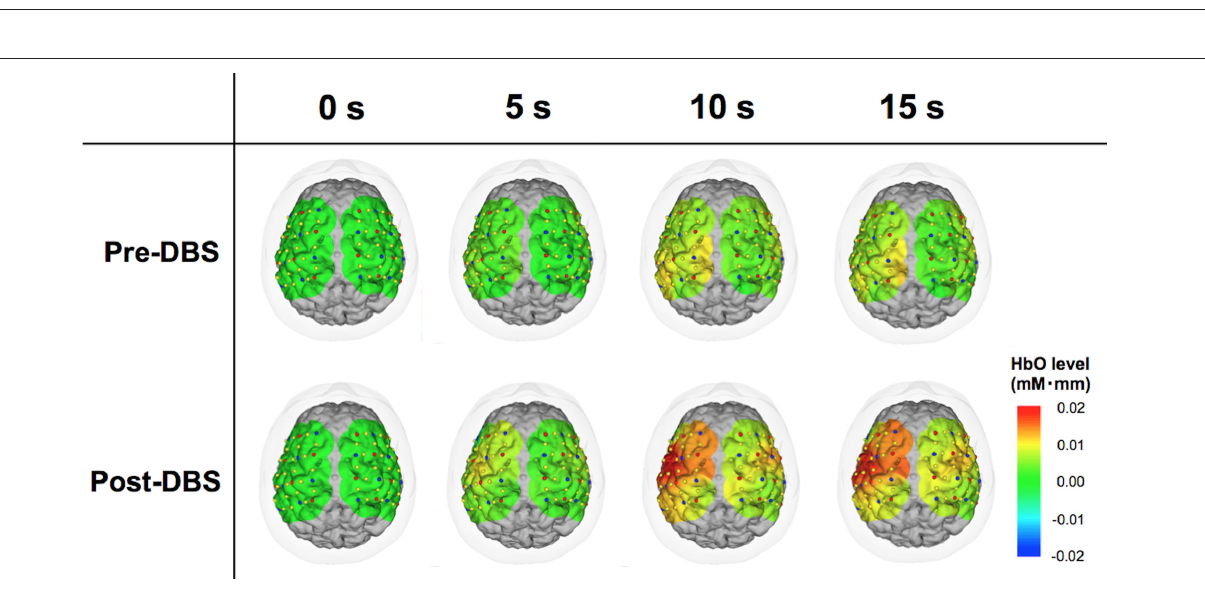
FIGURE 1 | Probe position on the head and estimated channel position on the individual and model brains. (A) Anterior view of the head with the cap. The arrow indicates the nasion where a landmark is for spatial registration. (B) Lateral view from the left. Probes were attached to 16 holes in the highlighted area. The arrow indicates the left tragus. (C) Lateral view from the right. Probes were attached to 16 holes in the highlighted area. The arrow indicates the right tragus. (D) Schema of the probe positioning. L, light source; D, detector; Ch, channel. (E) Estimated channel position on the 3-D model of the patient’s brain created from a volumetric T1-weighted image. Red and blue dots indicate the light sources and detectors, respectively. (F) Estimated channel position (yellow squares) on the model brain based on the Montreal Neurological Institute coordinate system.